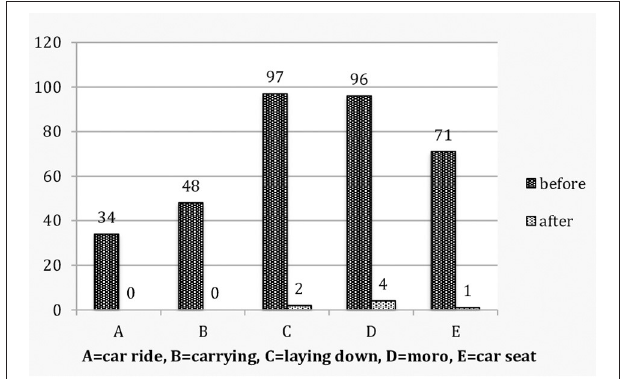
FIGURE 1 | Colicky babies: Vestibular score by individual characteristics before and after treatment.